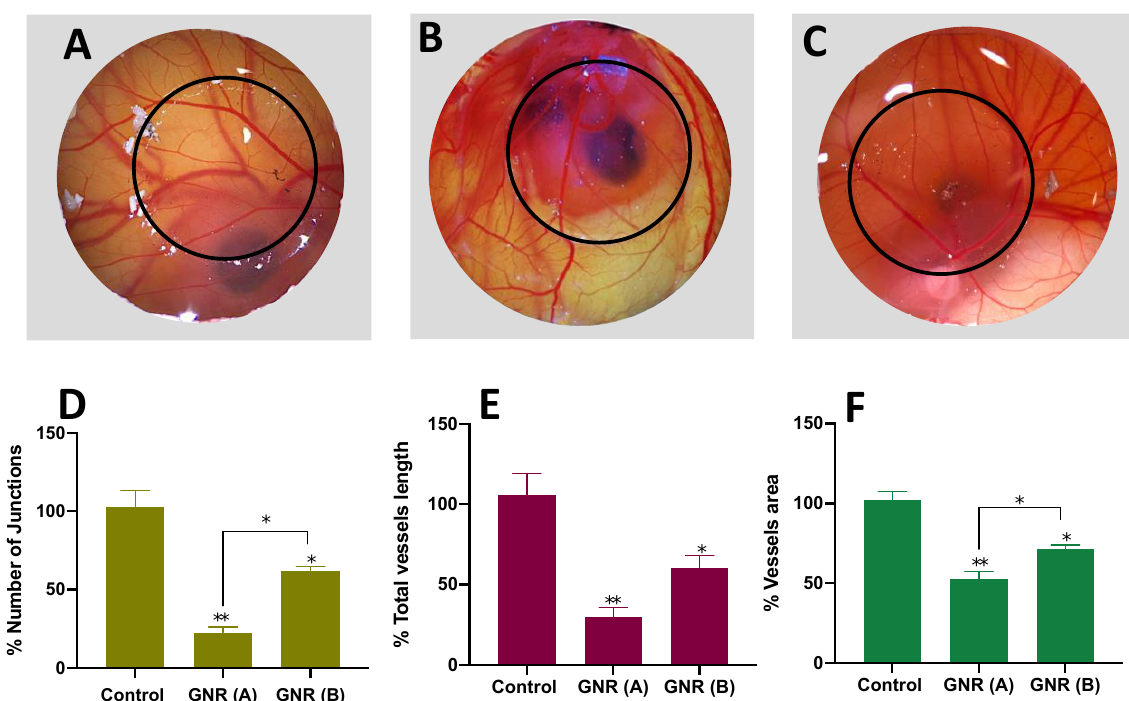
Figure 3. Angiogenesis of the CAM of chicken embryos: ( A ) untreated; ( B ) treated with GNR ( A ), and ( C ) treated with GNR ( B ). GNR ( A ) and ( B ) significantly inhibit the formation of new blood vessels compared to untreated CAM. Percentage of the number of junctions ( D ); total vessels length ( E ) and vessels area ( F ) in exposed areas compared to unexposed ones in the control CAM, and those treated with GNR ( A ) or GNR ( B ). Both GNR treatments significantly reduced the number of junctions, total vessels length, and vessels area in the exposed CAM compared to the control. Data are represented as mean ± SD, * p < 0.05, ** p < 0.01. Magnification: 10x.